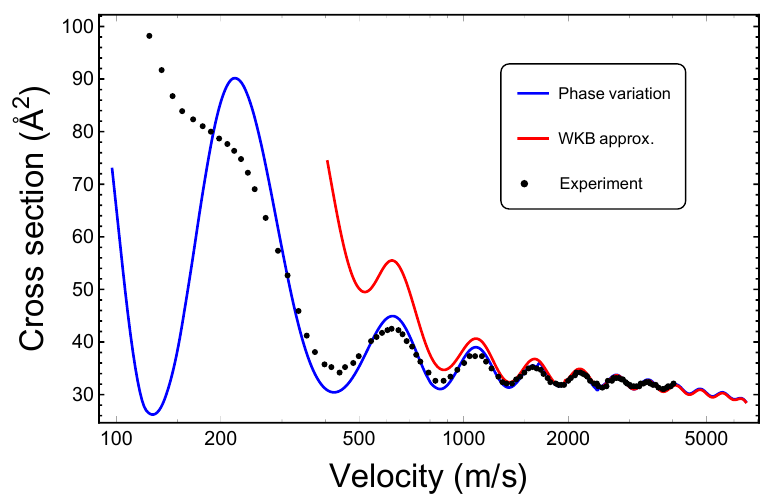
Figure 9 . The 4 He − 4 He scattering cross section as a function of the velocity of the initial helium beam in the lab frame. The experimental values (the black circles) are taken from [74]. We overlay the results from the two theoretical calculations discussed in the text, using the potential from figure 8 — the phase variation method (blue solid line) and the WKB method (orange solid line).